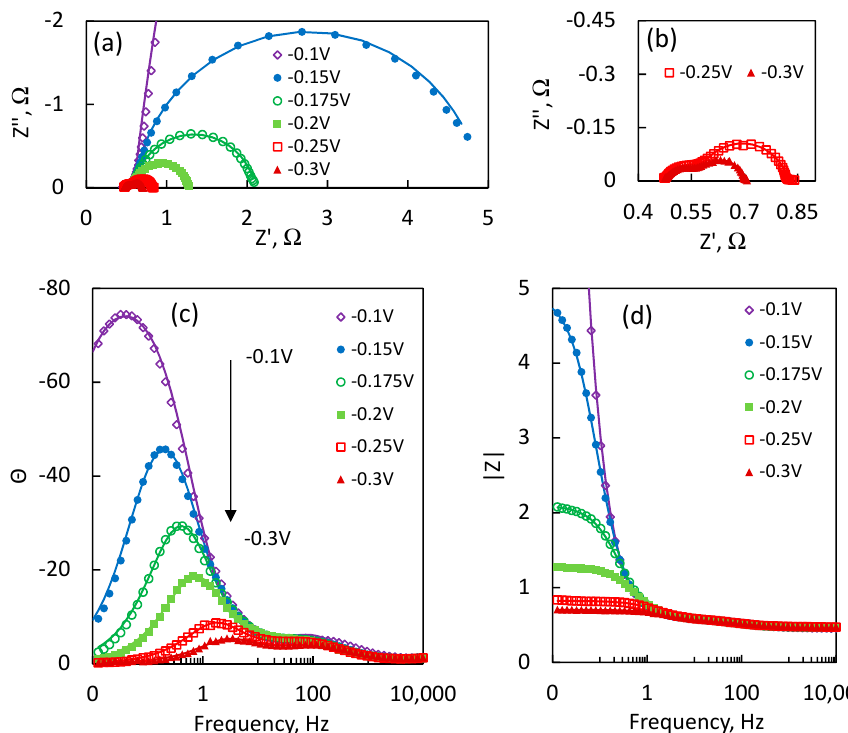
Figure 6. EIS spectra of HER from 0.5 M H 2 SO 4 on the electrodeposited MoS 2 film (Q = 10 C): ( a ) Nyquist plots obtained at various overpotentials; ( b ) spectra, obtained at higher overpotentials; and ( c , d ) Bode plots of respective overpotentials. Points are experimental data, while lines represent fitting to EEC shown in Figure 7.